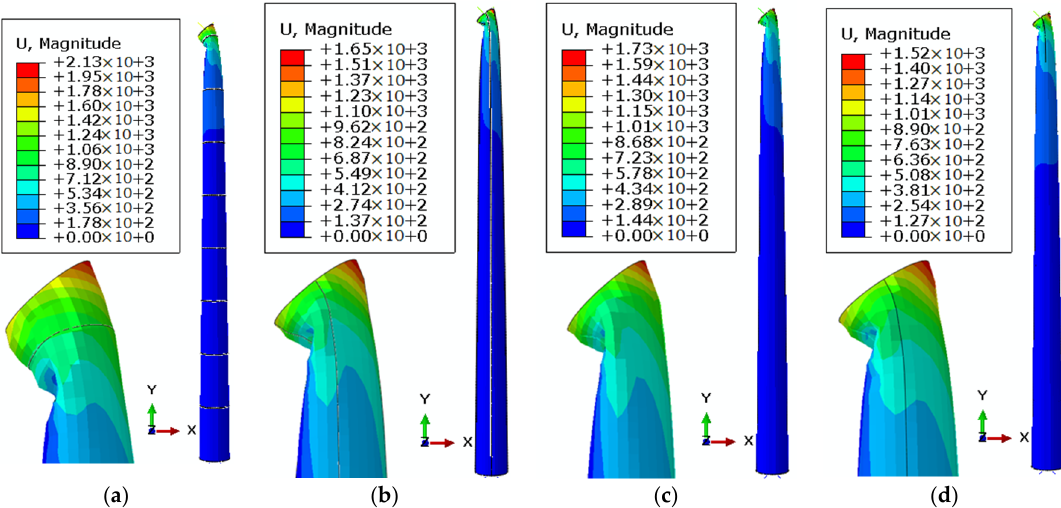
Figure 21. Post buckling behavior of Towers I, II, III, IV: ( a ) Tower I, ( b ) Tower II, ( c ) Tower III, ( d ) Tower IV, (in mm).